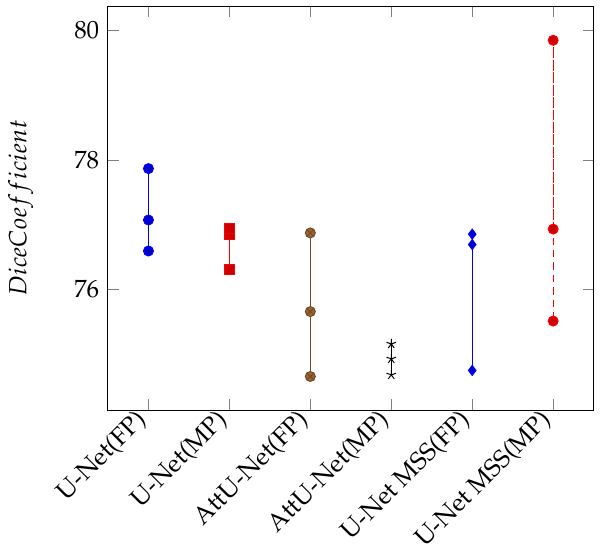
Figure A4. Dot plot for Models trained with full precision (FP) and mixed precision (MP) using Apex, tested with three 7T